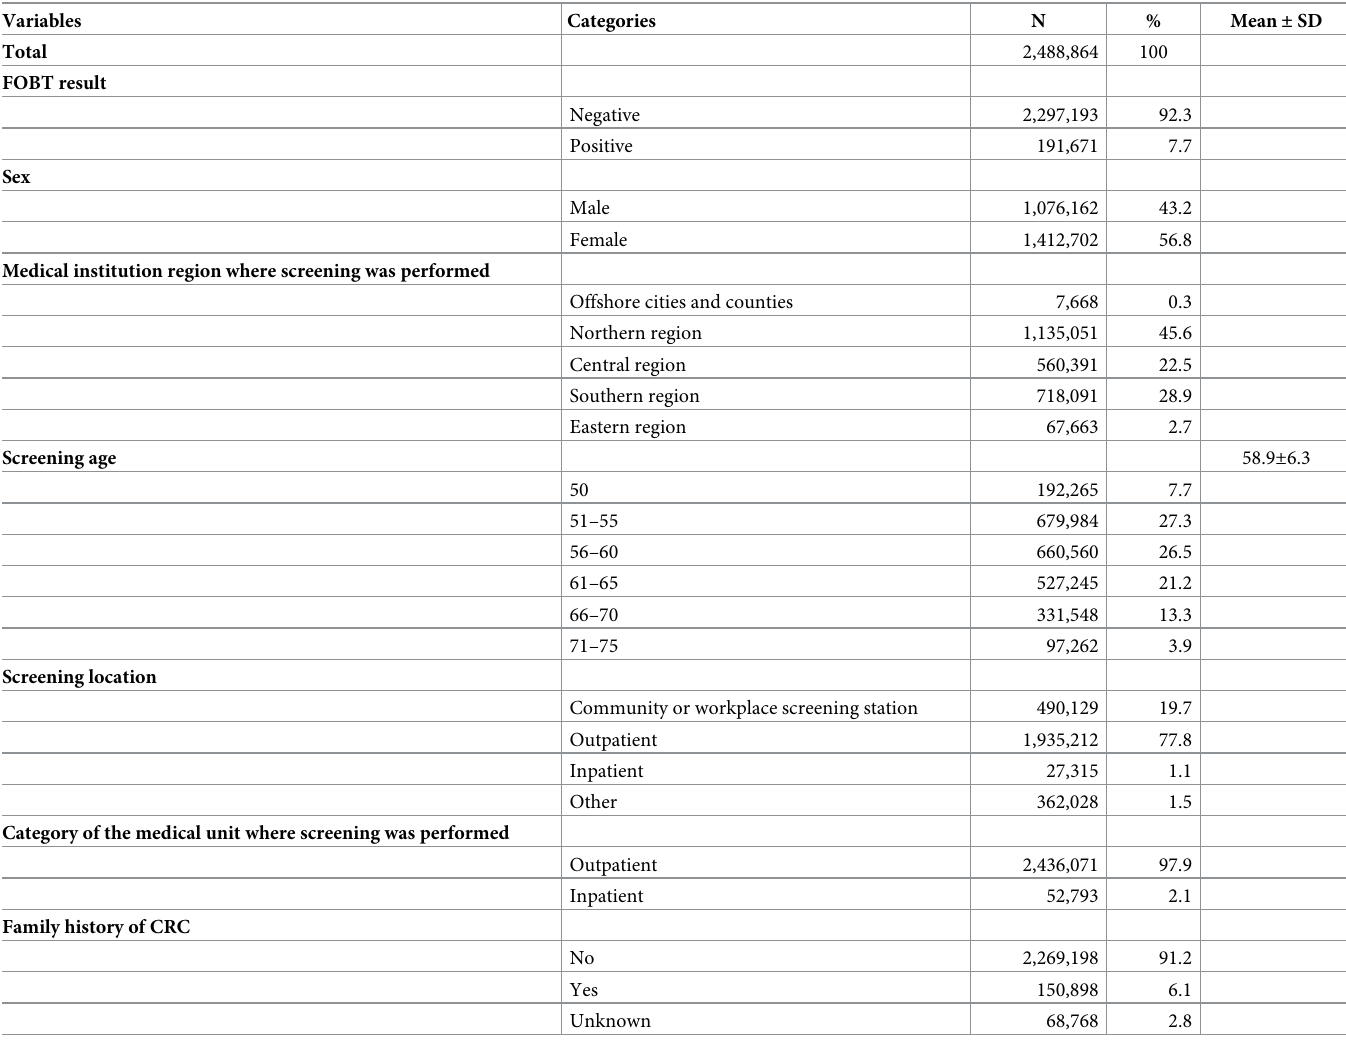
Table 1. General information of people aged 50–75 undergoing the